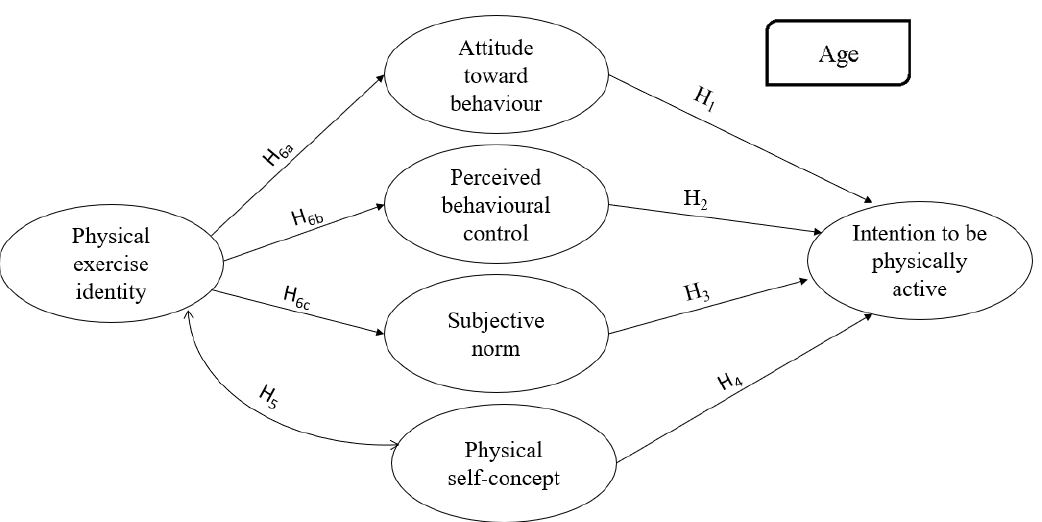
Figure 1. Hypothetical model of the intention to be physically active after finishing secondary school and associated variables with the TPB, including physical exercise identity, and physical self-concept. directly and